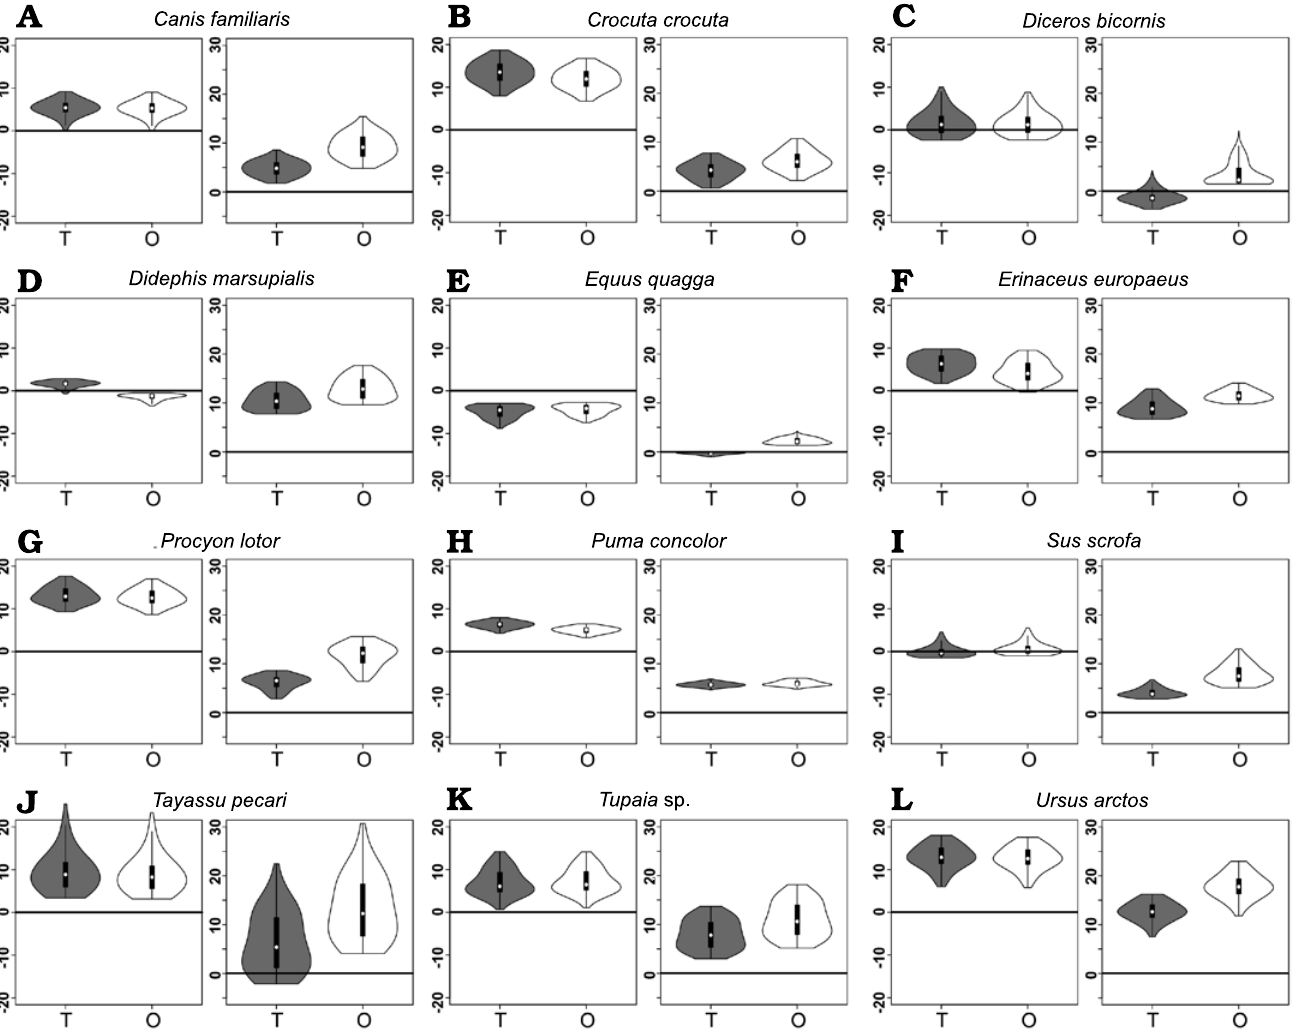
Fig. 7. Violin boxplots showing distribution of Group 1 minus Group 2 values (on left) and closed gape minus open gape values (on right) for N = 12 representative extant therians. A . Canis familiaris (domestic dog). B . Crocuta crocuta (spotted hyaena). C . Diceros bicornis (black rhino). D . Didephis marsupialis (opossum). E . Equus quagga (quagga). F . Erinaceus europaeus (European hedgehog). G . Procyon lotor (racoon). H . Puma concolor (moun- tain lion). I . Sus scrofa (domestic pig). J . Tayassu pecari (white-lipped peccary). K . Tupaia sp. (treeshrew). L . Ursus arctos (brown bear). Abbreviations: T, total bite force; O, orthal bite force. Vertical axes represent magnitude values in